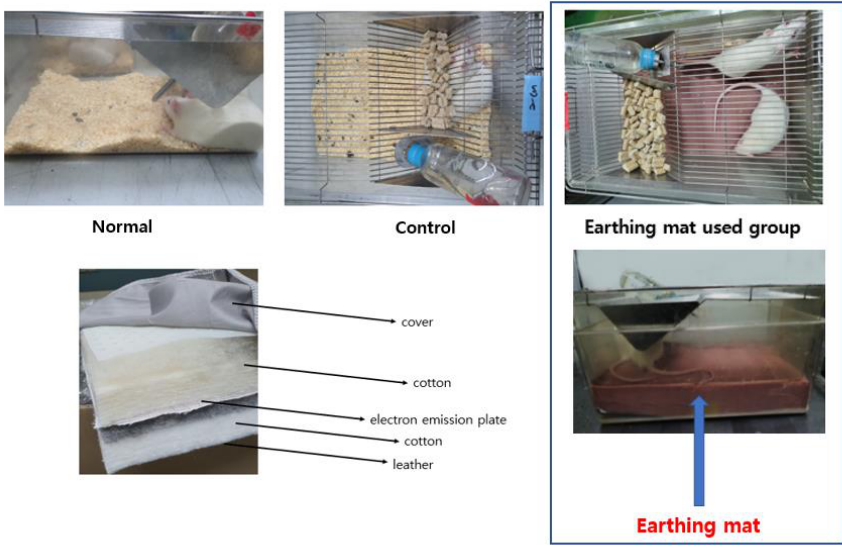
Figure 1. Experimental schedule.